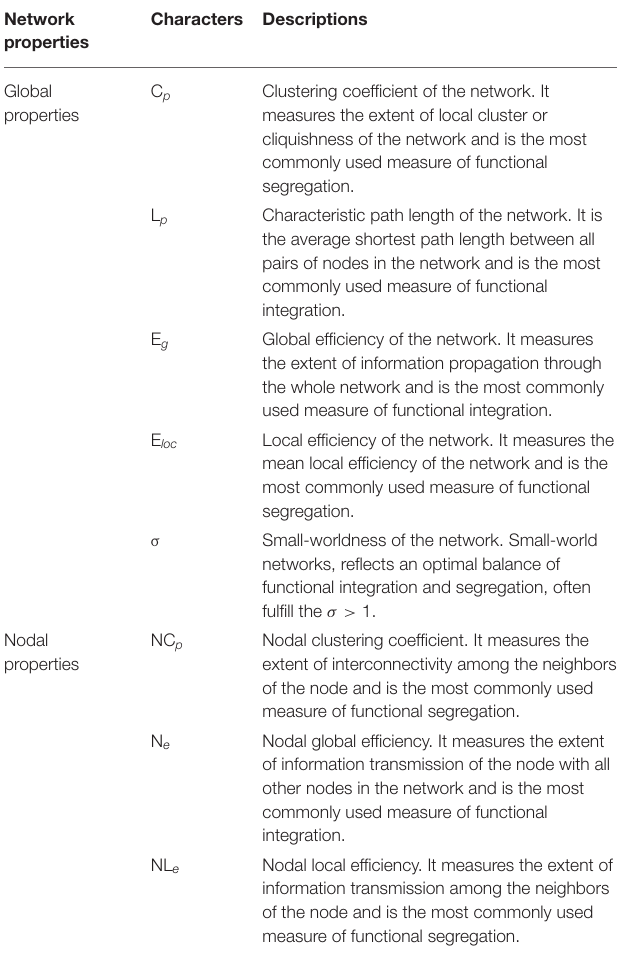
TABLE 2 | Topological parameters of the brain functional